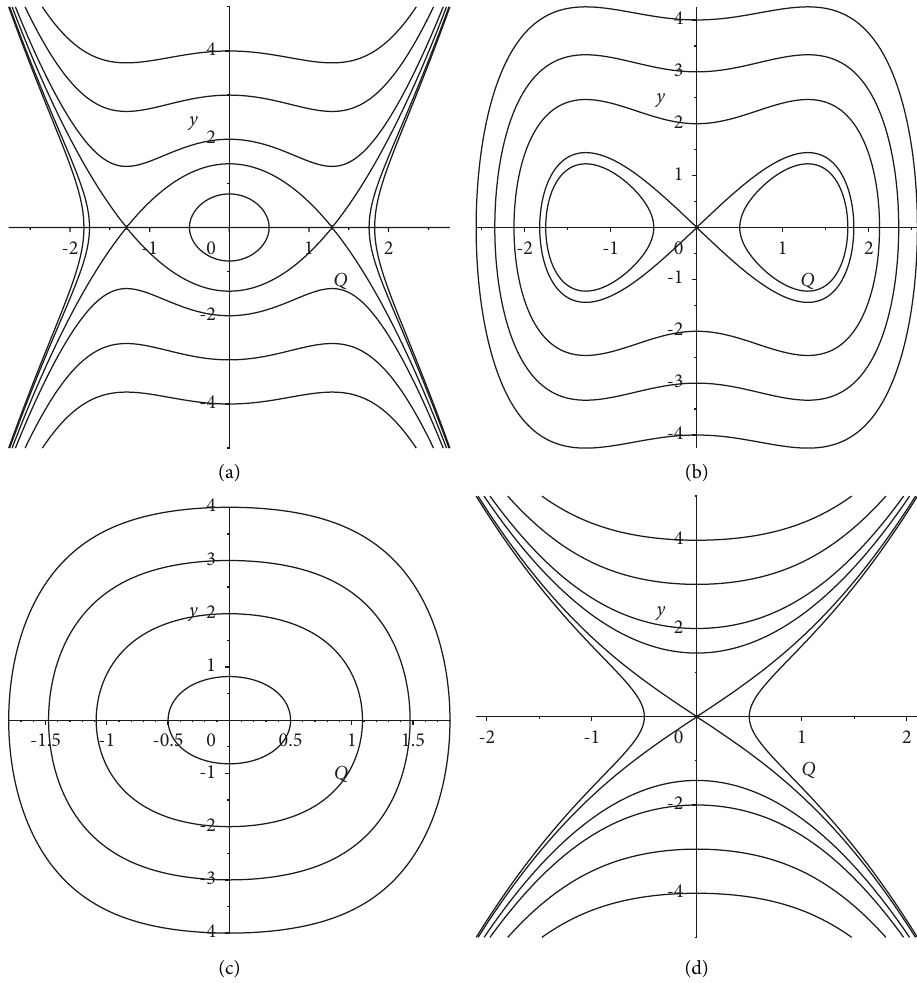
Figure 1: The phase portraits of system (8). (a) A